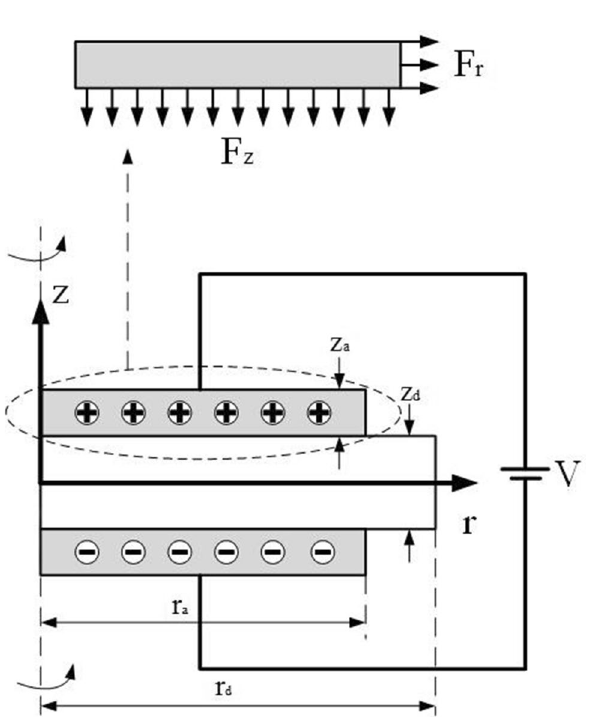
Figure 4. Symmetric rotation diagram of electrostatic